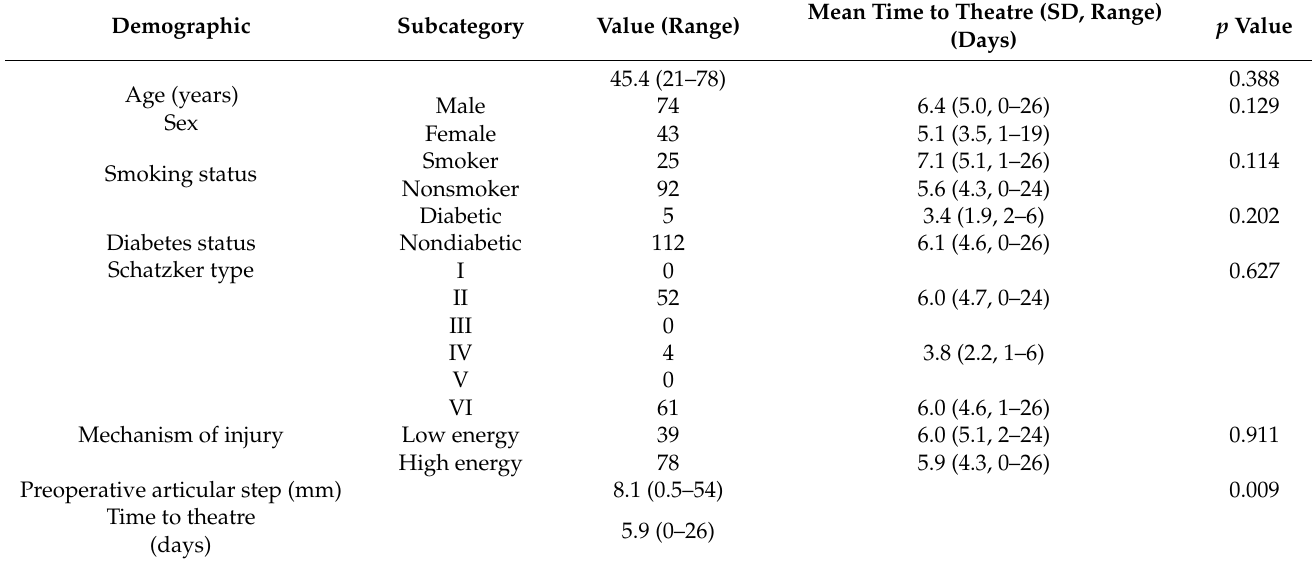
Table 1. Patient demographics and their relationship to time to